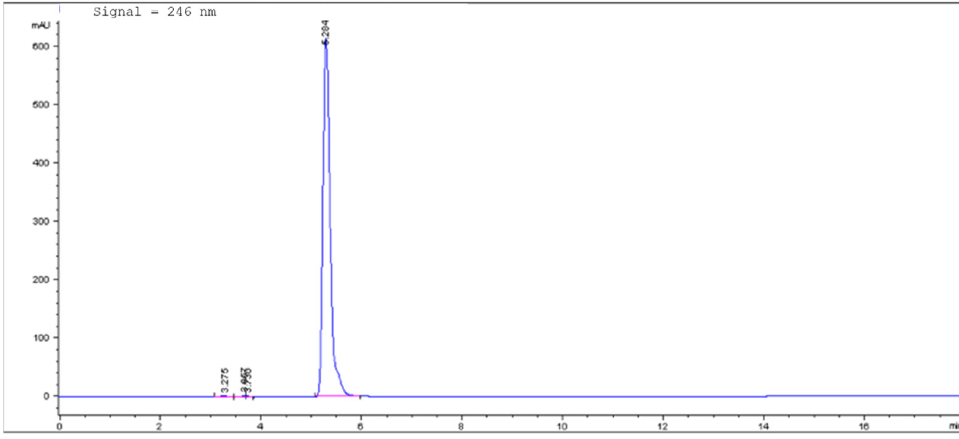
Figure 4. HPLC-DAD chromatogram of khellin at 246